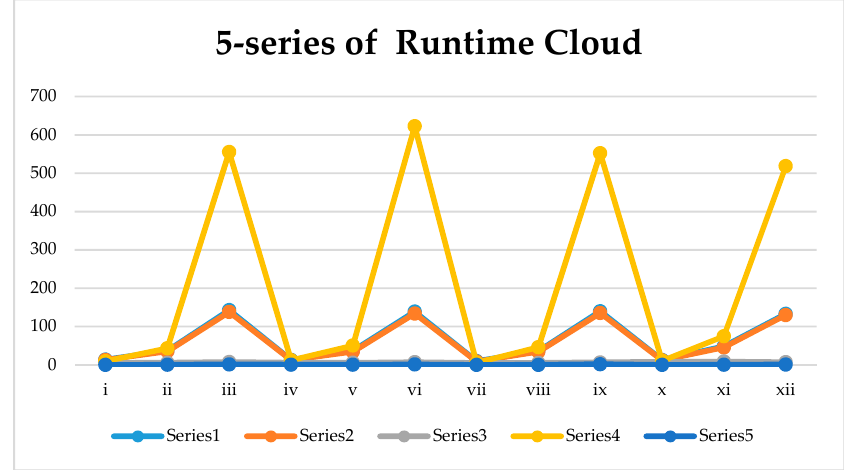
Figure 5. 5-series of runtime comparative studies of existed